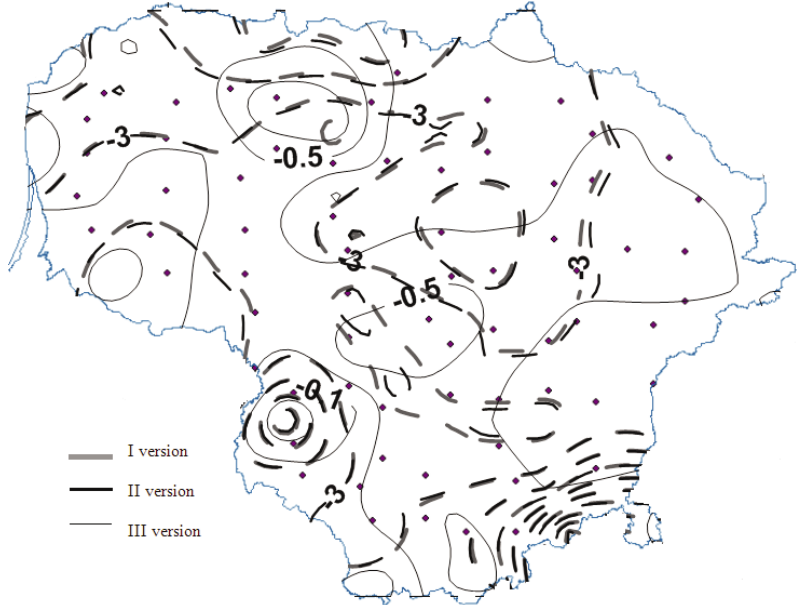
Fig. 3. The isogram of the minimum related